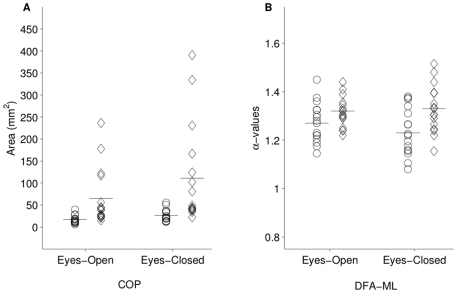
Vision x diagnosis interactions for COP (Panel A) and DFA-ML (Panel
B).Each participant's data is represented by a single data point in the
eyes-open and eyes-closed condition in each panel. COP increased more
dramatically for bipolar disorder participants (diamonds) than for
controls (circles). DFA-ML decreased for controls, but was relatively
unaffected in bipolar disorder, suggesting that the patient group was
less able to compensate for the loss of visual information by using
vestibular or proprioceptive information.